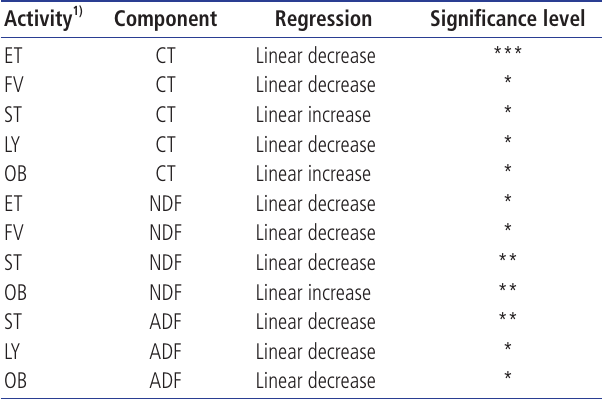
Table 8. Relationship between behavioral activities against condensed tannins and fiber on behavioral Significance levels